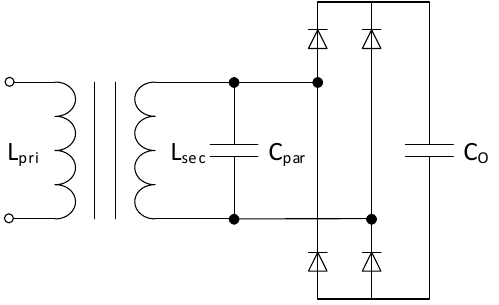
Figure 3. Simulation model with high-voltage high-frequency transformer equivalent diagram loaded with Graetza rectifier and capacitor. Lpri—primary winding inductance, Lsec—secondary winding inductance, Cpar—capacitance being the sum of the parasitic capacitances of the secondary winding, C O —load capacitor.